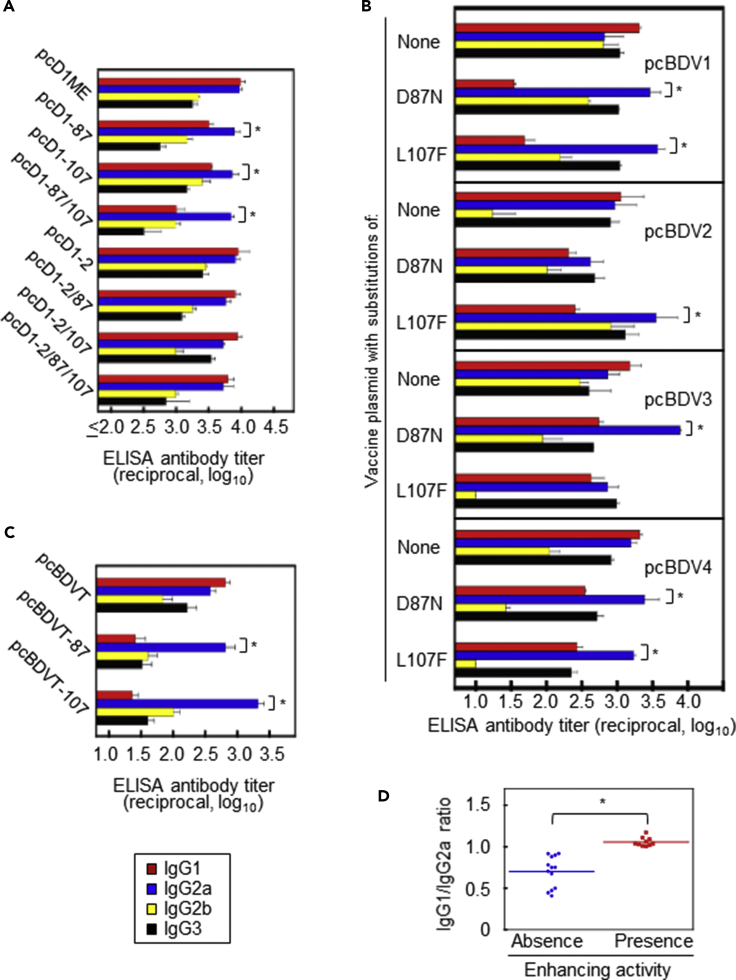
IgG Subclass Antibody Levels in Mice Immunized with Mutated DNA Vaccines(A–C) ELISA antibody titers of each IgG subclass against the DENV-1 Mochizuki strain were determined using the mouse serum samples obtained in (A) Figure 2, (B) Figure 3, and (C) Figure 4. The endpoint titer is expressed as the maximum serum dilution that displayed an optical density (OD) value of ≥0.5. For cases in which the OD value was <0.5 at the 1:20 serum dilution, the titer was defined as 1:10. Mouse IgG1, IgG2a, IgG2b, and IgG3 are shown in red, blue, yellow, and black, respectively. Asterisks indicate significant differences (p< 0.05) between IgG1 and IgG2a levels.(D) Summary of the IgG1/IgG2a ratios in mouse sera, divided into groups based on the presence or absence of enhancing activity. The asterisk indicates a significant difference (p< 0.05).